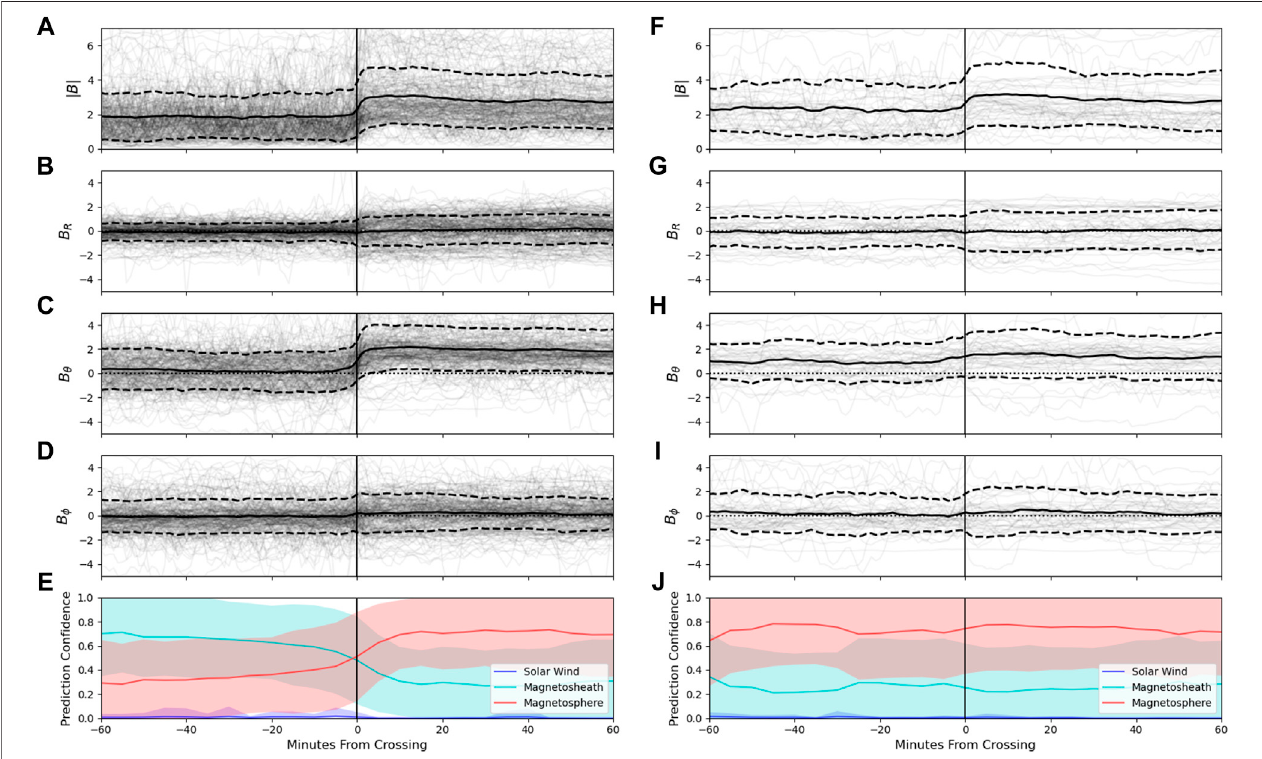
FIGURE11| Comparison ofthemagnetopause crossingsin thelabeled datasetwhichwerematchedtoapredicted crossing (A – E) ,versusthose whichwere not matched (F – J) in the RNN 60-min model predictions. Panels (A – D) and (F – I) show the magnetic fi eld conditions in a 1-h vicinity surrounding the labeled crossing, with individual instances plotted as transparent black lines. The average conditions ± the standard deviation are shown as thick black solid and dotted lines, respectively. Panels (E,J) show the prediction con fi dence of the model surrounding the labeled crossing for matched (E) and unmatched (J) crossings, with the average ± the standarddeviationshownintheshadedregion.Heretheinwardsandoutwardscrossingshavebeenoverlaid,suchthatallcrossingsareorientedinainwardstrajectory. In total there were 216 matched crossings and 47 unmatched crossings (see Table 4